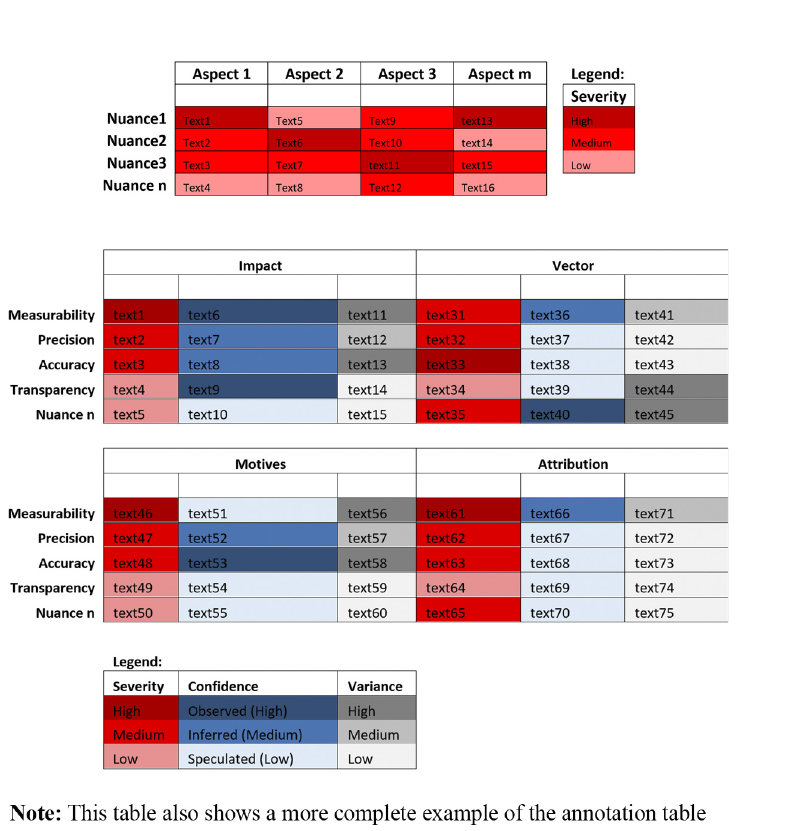
Figure 3. An n (cid:3) m matrix showing – the text in